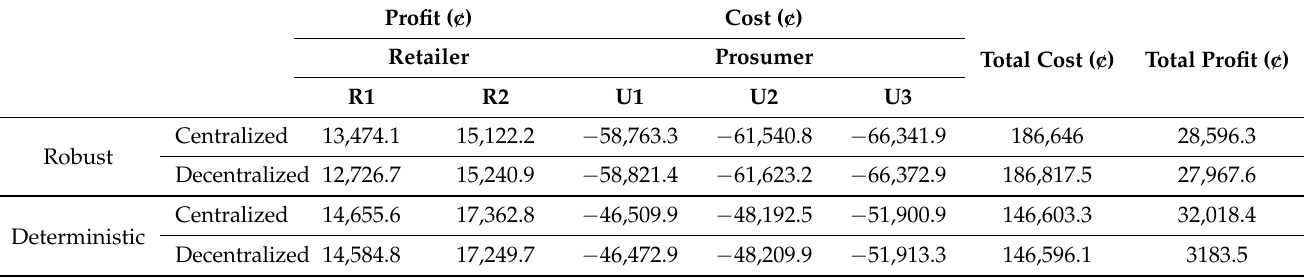
Figure 9. The thermal power balance of prosumers along with the gas price. Table 1. A comparison of the proposed decentralized and centralized methods for deterministic and robust